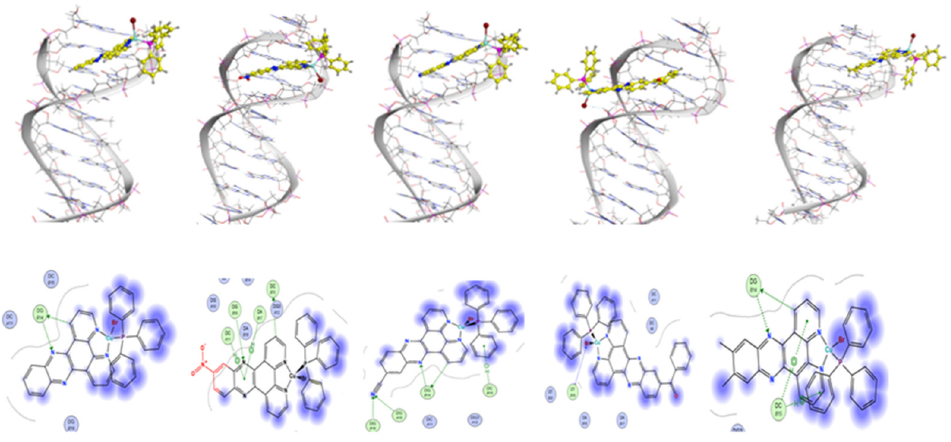
Figure 9. Illustration of the non-covalent interactions (2D and 3D) of Cu-compounds with B-DNA as estimated by MOE.